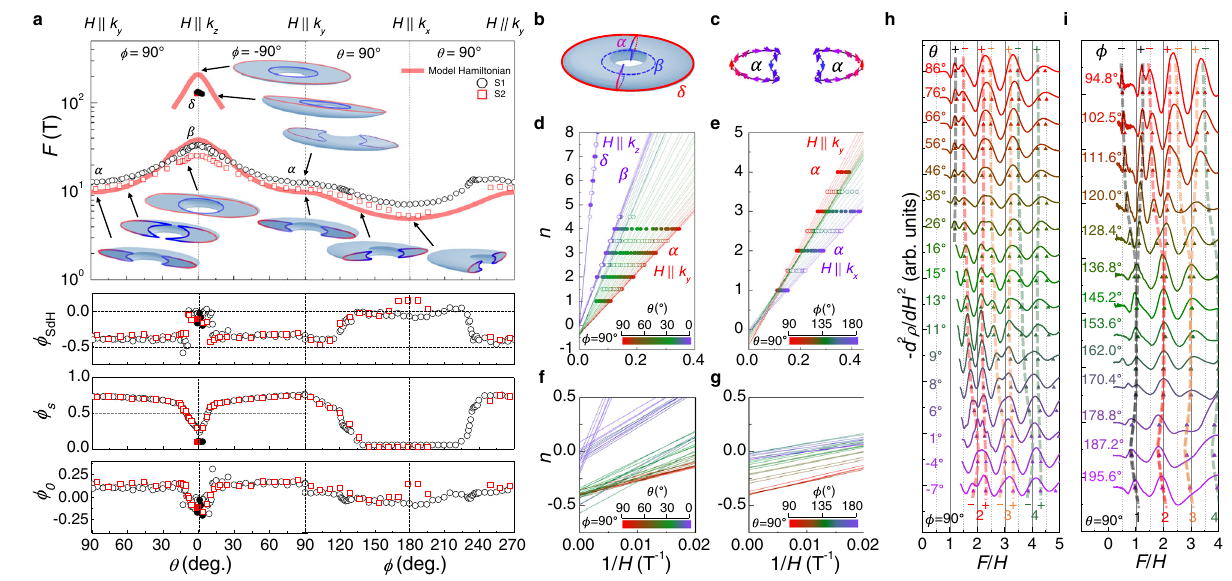
Fig. 3 | Toroidal Fermi surface and Berry phase evolution of SrAs 3 . a Angle- dependentSdHfrequency( F )andthephaseoffsetofSdHoscillation( ϕ SdH )fortwo samplesS1(black) and S2(red).The spin-splitting phase ( ϕ s ) and the characteristic phase ( ϕ 0 ) are also shown in the lower panels. The calculated F using the model Hamiltonian is overlaid with red lines. The corresponding extremal orbits on the torus-shapedFermisurface are also presented for selected fi eldorientations inthe inset. b Torus-shaped Fermi surface of SrAs 3 with the poloidal orbit ( α ) and the inner ( β ) and outer( δ )toroidalorbits. c Poloidalcross-sectionof the Fermisurface ( α ) with pseudospin textures indicated by the arrows. d – g Landau fan diagram for